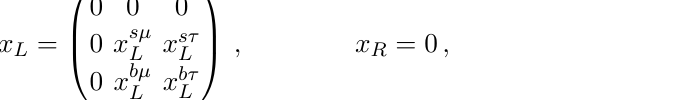
Table 2 . Summary of the LQ models which can accommodate R column), and both R and R (third column) without inducing other phenomenological prob- K ( (cid:3) ) D ( (cid:3) ) lems. The symbol 7 (cid:3) means that the discrepancy can be alleviated, but not fully accommodated. See text for